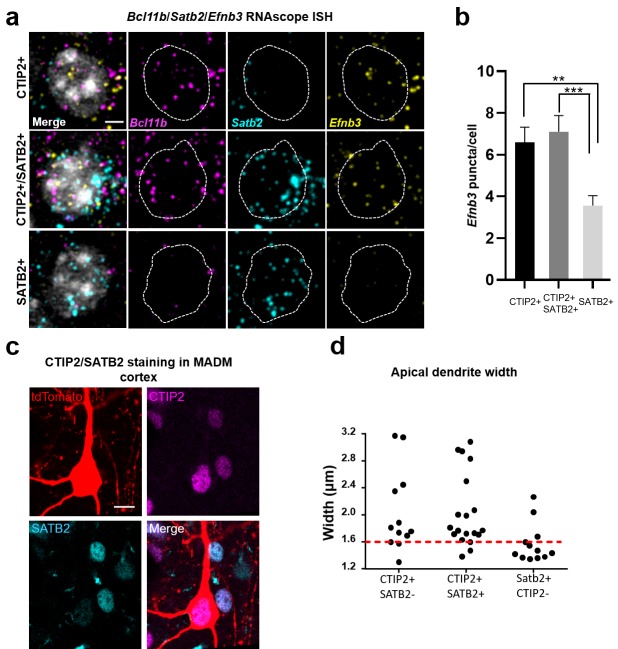
Efnb3 is expressed in CTIP2 +projection neurons.(a) Representative cells within WT mouse cortex labeled by RNAscope ISH for CTIP2 mRNA (Bcl11b), SATB2 mRNA (Satb2), and eB3 mRNA (Efnb3). Scale bar, 3 μm. (b) Quantification of the number of RNAscope ISH eB3 puncta per cell across the indicated cell types (CTIP2+, n = 72; CTIP2+/SATB2+, n = 69; SATB2+, n = 93; F (2, 231)=9.332, p=0.0001, one-way ANOVA, ***p=0.0004, **p=0.0026 *, Tukey’s post hoc.) (c) Representative image of a tdTomato+/CTIP2 +cell in MADM cortex co-labeled with CTIP2 and SATB2 antibodies. Scale bar, 10 μm. (d) Analysis of apical dendrite width in subgranular neurons expressing CTIP2 and/or SATB2. Most neurons expressing CTIP2 have large (>1.6 μm) dendrites.10.7554/eLife.41563.016Figure 5—source data 1.Efnb3 is expressed in CTIP2 +projection neurons.